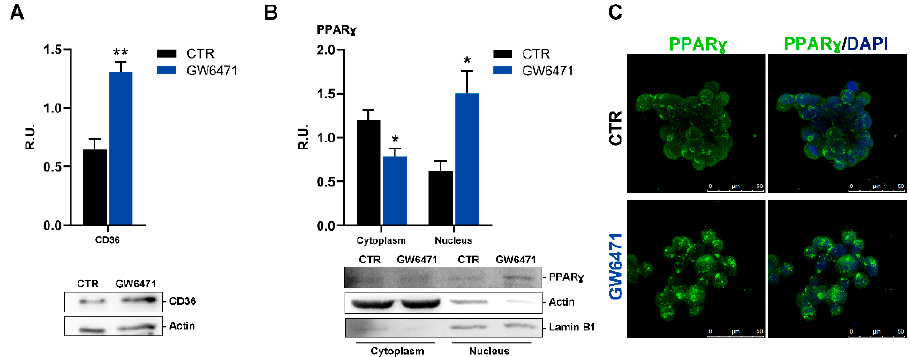
Figure 5. ( A ) Western blotting and relative densitometric analyses for CD36 in control and treated mammospheres. ** p < 0.005 vs. CTR ( n = 3). ( B ) Western blotting and relative densitometric analyses for cytosolic and nuclear PPAR γ of control and treated mammospheres. A representative western blot image is shown. * p < 0.05 vs. CTR ( n = 3). ( C ) Immunofluorescence representative figure for PPAR γ (in green) analyzed in control and treated mammospheres. In blue, the nuclei are stained with DAPI. A representative figure is shown. Scale bar: 50 µm.